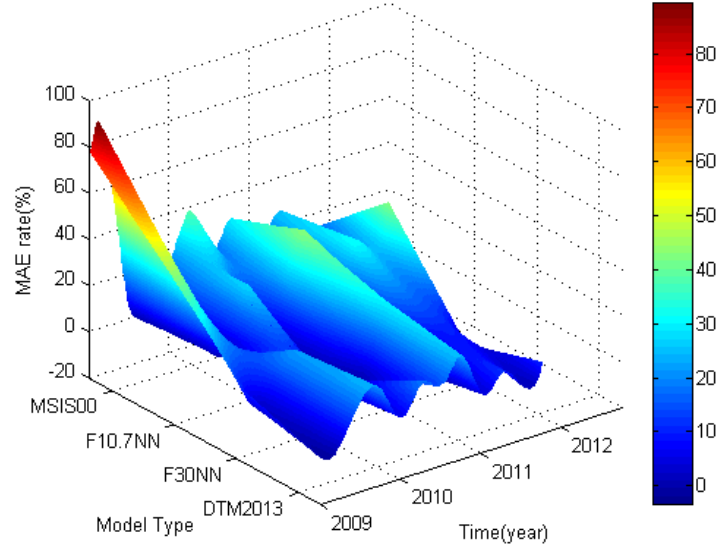
Fig. 8. Simulation MAE rates of 4 models